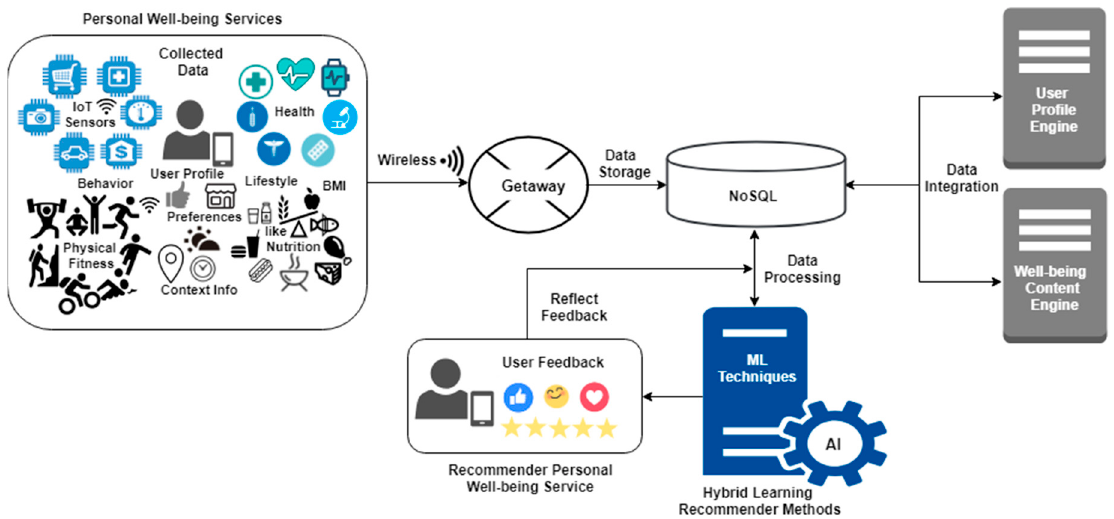
Figure 1. Well-being recommender services .